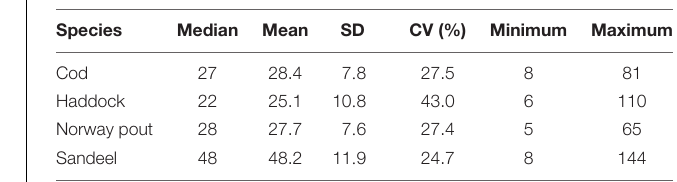
TABLE 1 | Overall median, mean, standard deviation (SD), coefficient of variation (CV), and minimum and maximum length (mm) at the 0-group stage of cod, haddock, Norway pout, and sandeel within the CS 1983–2018.